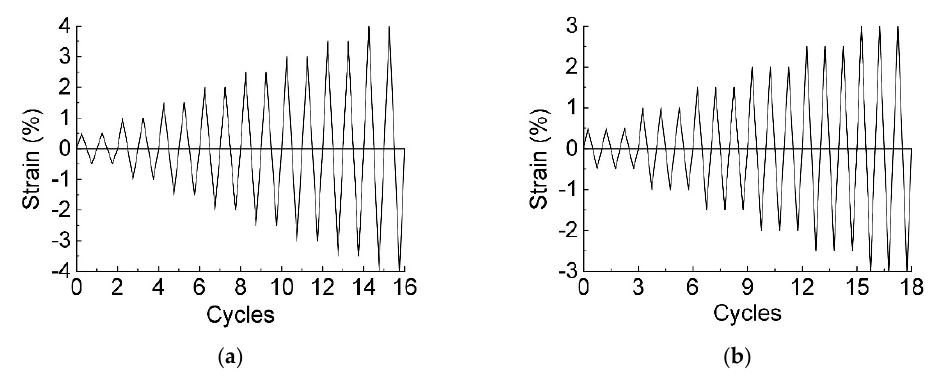
Figure 4. Loading protocol. ( a ) Q235 and Q345; ( b ) S304 and S316.